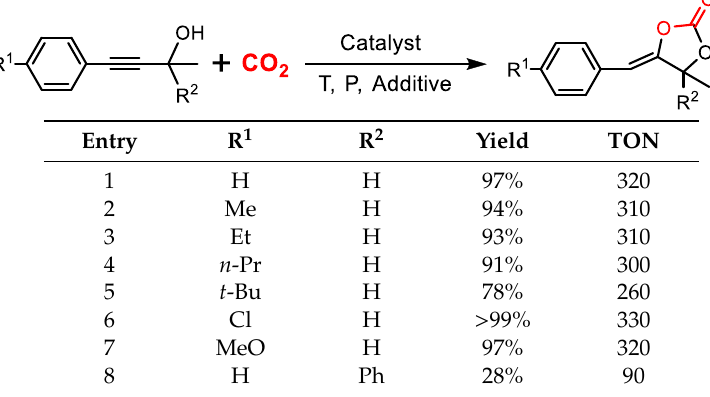
Table 2. 1 -catalyzed cyclization of propargylic alcohols with CO 2 .